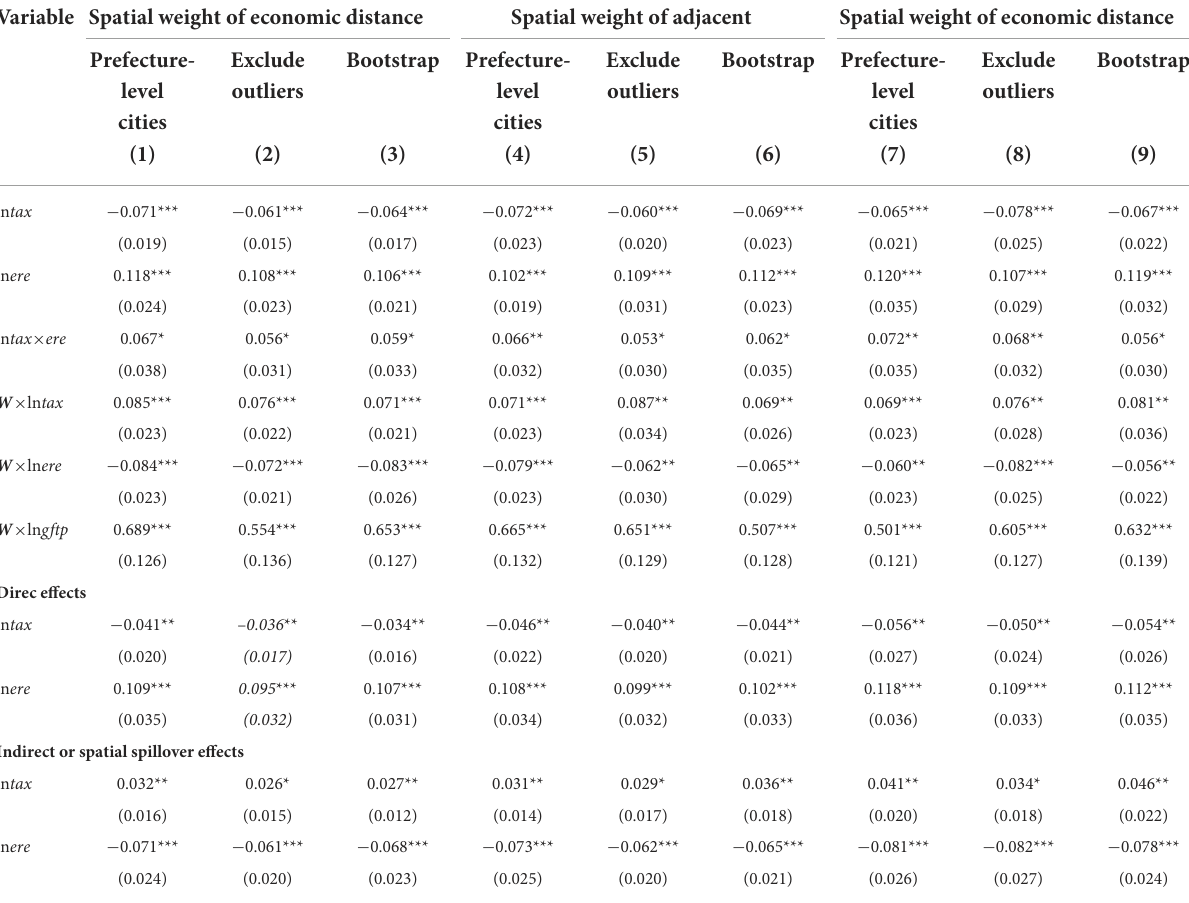
TABLE 7 The results of the Robustness